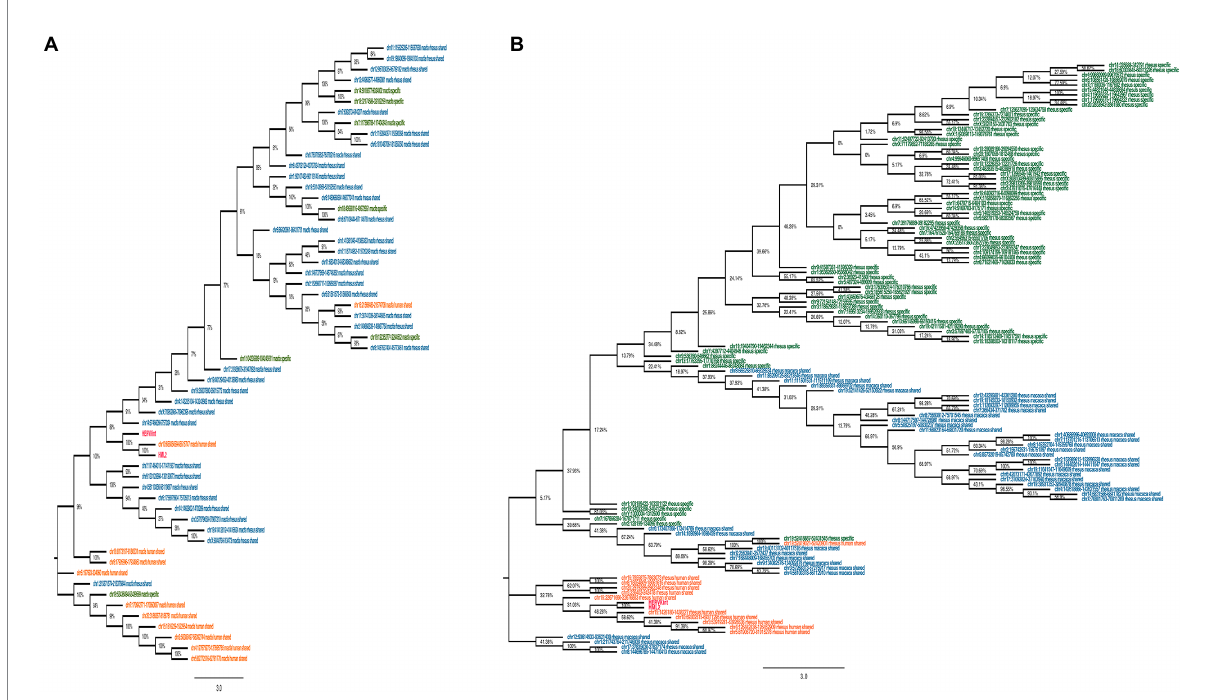
FIGURE 2 Phylogeny of HML2 loci in Old World Monkeys Macaca fascicularis and Macaca mulatta . Both trees represent the HML2 sequences that are specific to individual species (green), some common among the species (blue), and some shared with humans (orange). Lastly, the reference sequences are highlighted in red. Only the full-length sequences were included to generate the phylogeny by applying Neighbor-joining method with 500 bootstrap values in MEGA 11